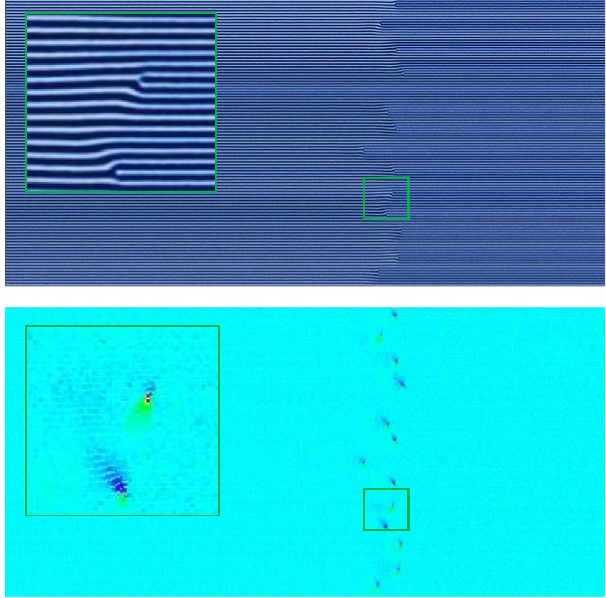
Figure 9. Simulation results for CZA with horizontal templating with a template spacing of L || = 7 L o at a zone velocity of v zone = 0.103. At this velocity, the alignment is predominantly parallel with a few dislocation-type